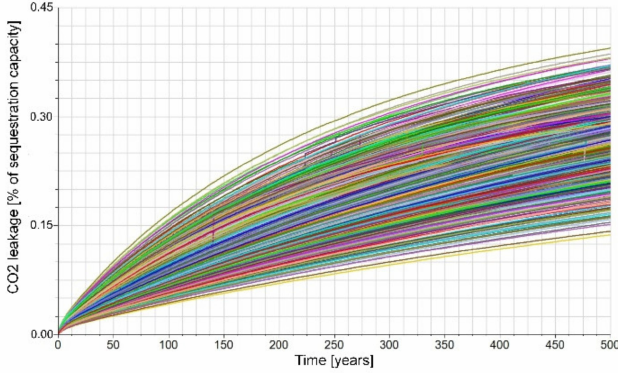
Figure 18. CO 2 leakage into the overburden vs. time. Ensemble no. 2.